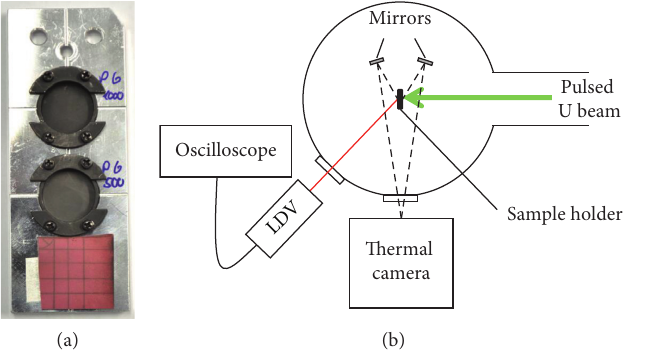
Figure 1: (a) Sample holder with two graphite samples mounted above a luminescence screen. (b) Schematic setup for online monitoring of elastic waves using a laser Doppler vibrometer and a thermal camera. The experiments were conducted at the M3 beamline at the UNILAC of